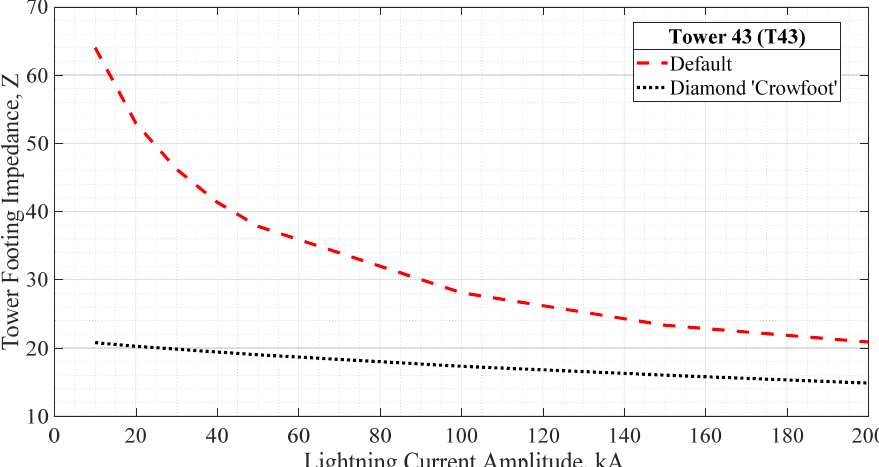
Energies 2021 , 14 , x FOR PEER REVIEW 16 of 20 Figure 15. Variation of lightning current amplitude for Tower T43. Figure 15. Variation of lightning current amplitude for Tower T43. Figure 15. Variation of lightning current amplitude for Tower T43.